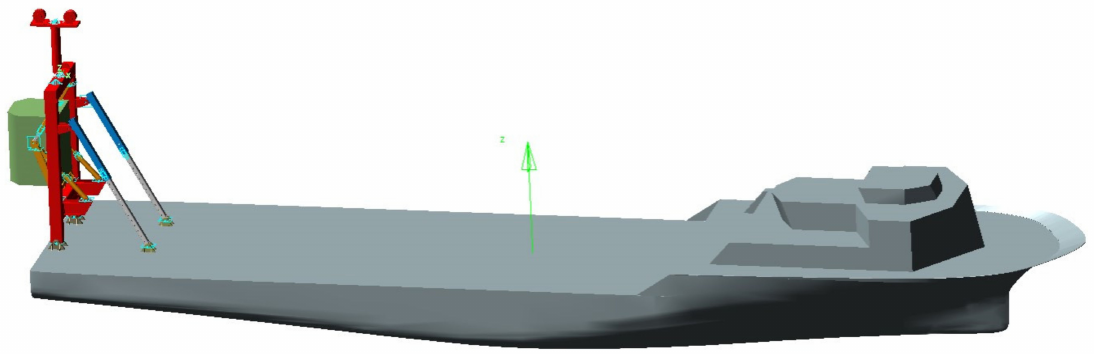
Figure 5. Simulation model (scaled model) in Adams.